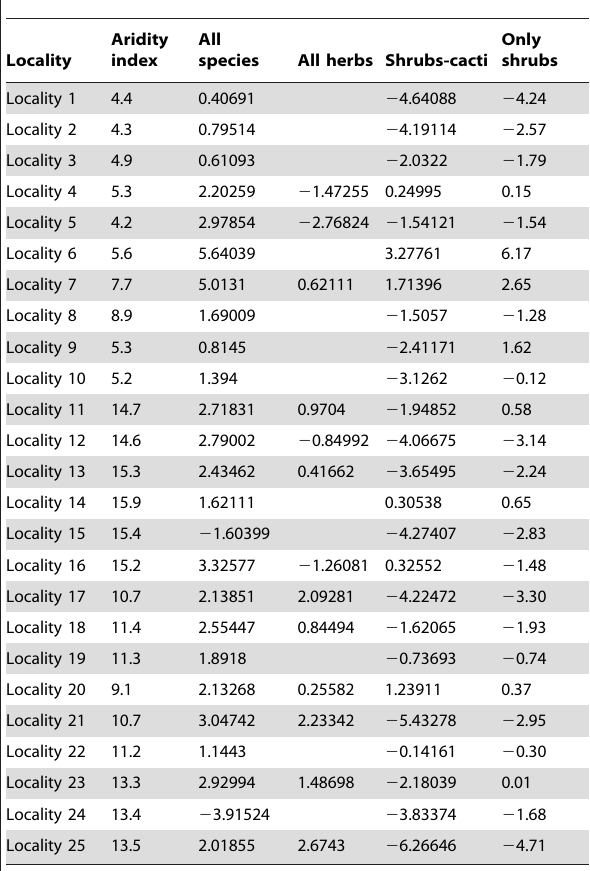
Table 2. Species co-occurrence across localities (a) with different aridity levels (b) within the subtropical Andes; standardized C-score values (SES) for all species combined (c) and for specific life forms (d-f) are